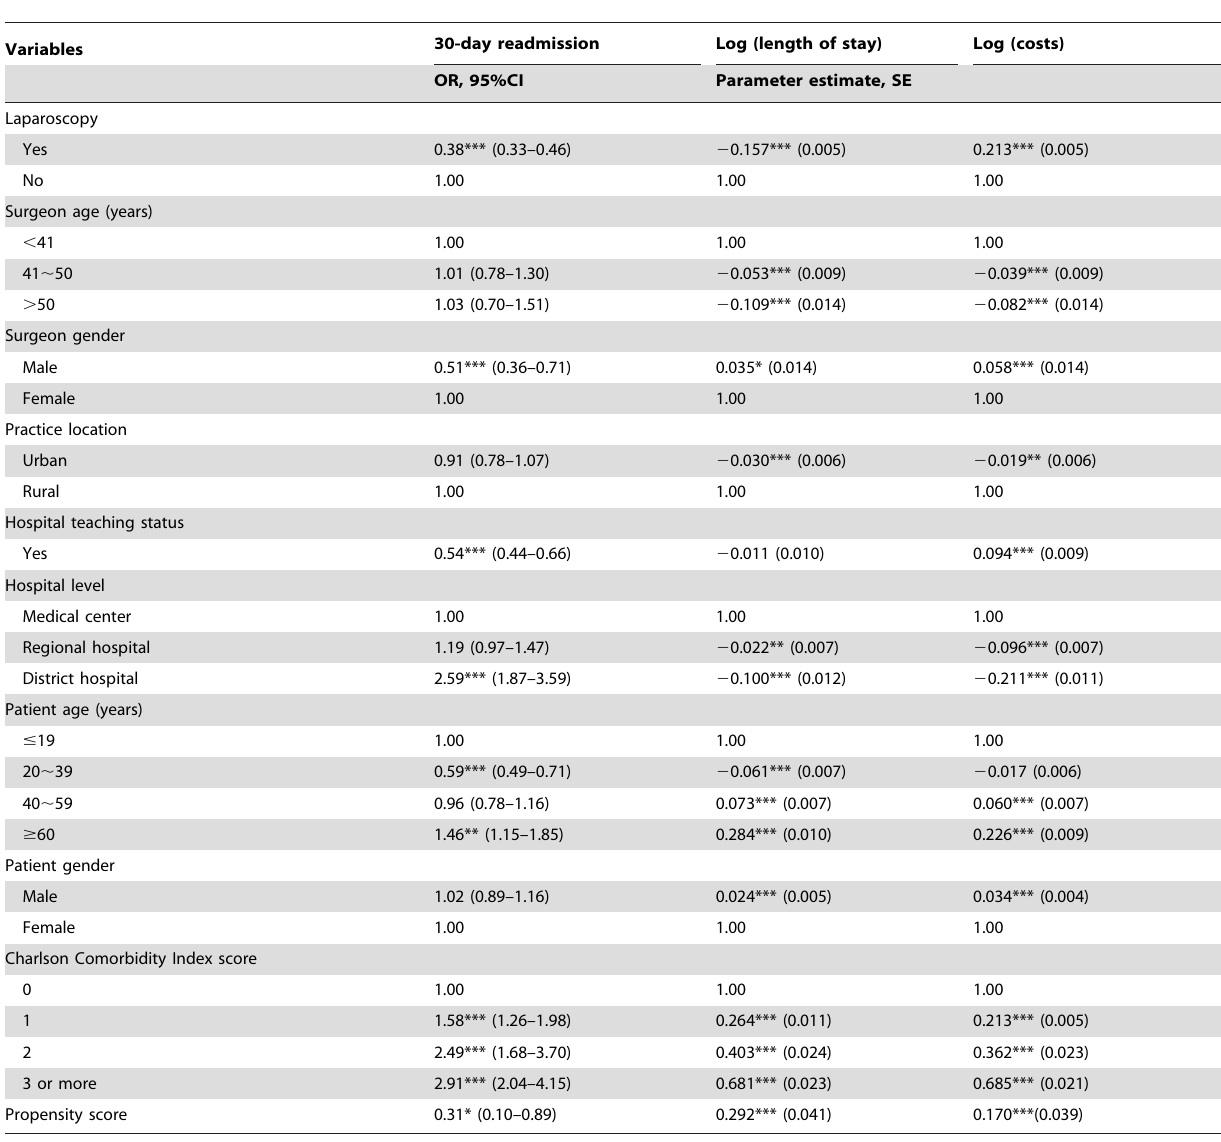
Table 3. Adjusted relationships between 30-day readmission, length of stay, cost per discharge, and the use of laparoscopy.